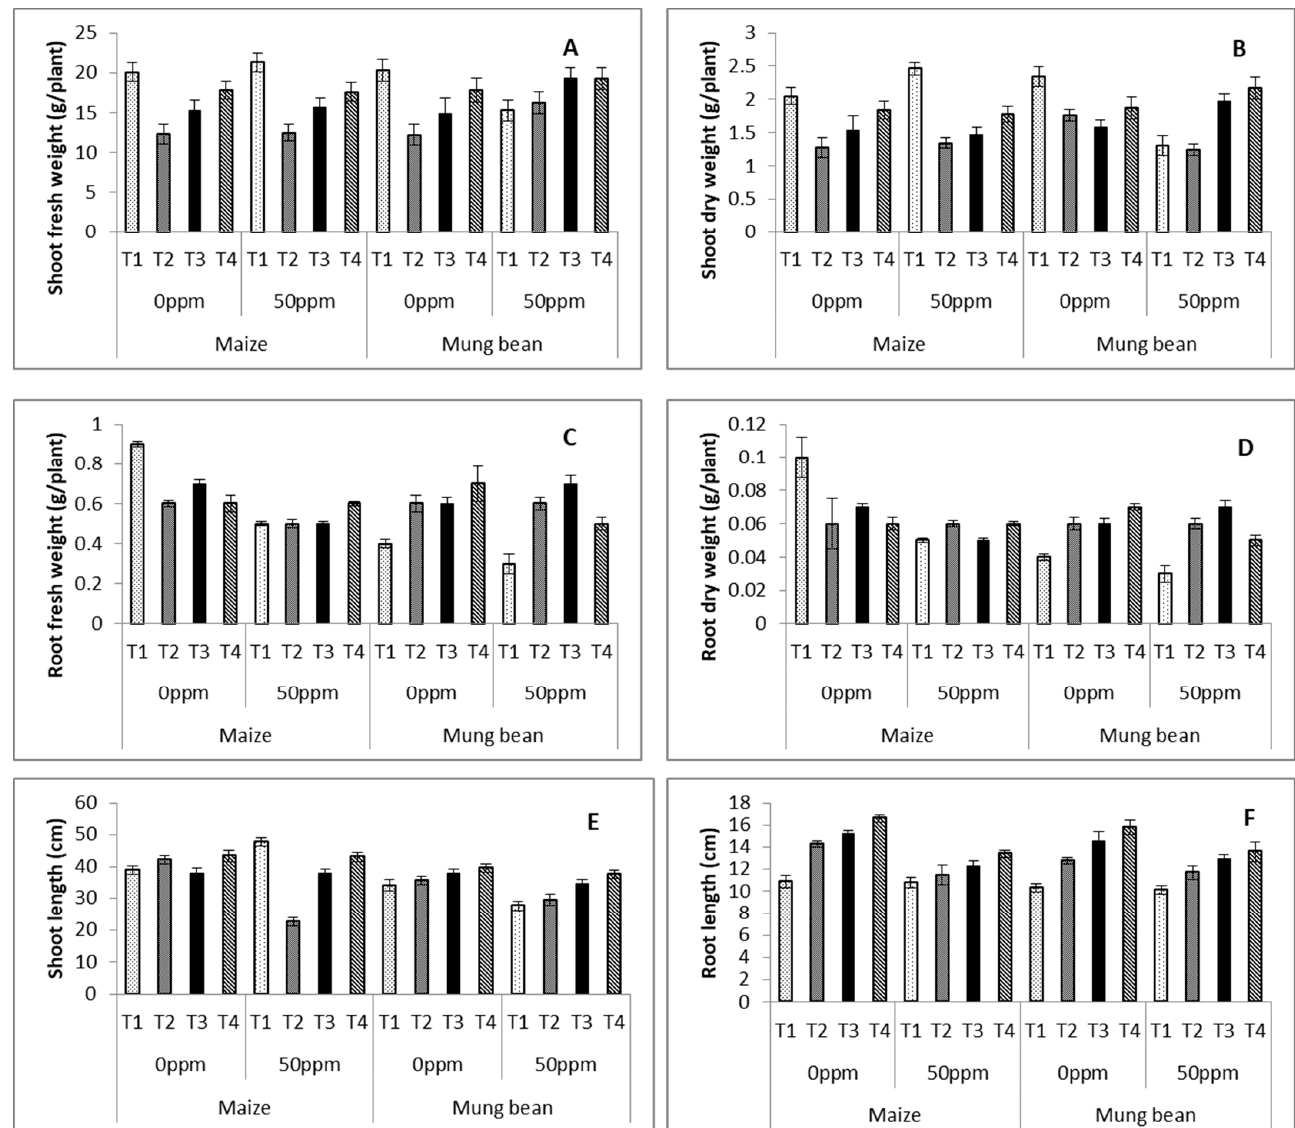
Figure 2. Shoot fresh ( A ) and dry ( B ) weights, root fresh ( C ) and dry ( D ) weights, shoot ( E ) and root ( F ) lengths, of maize ( Zea mays L.) and mung bean ( Vigna radiata L.) exogenously treated with B. subtilis under chromium stress conditions (mean ± S.E.). Here, T1 = Nutrient broth, T2 = Nutrient broth + parent B. subtilis , T3 = Nutrient broth + UV irradiated B. subtilis and T4 = Nutrient broth + γ‐ irradiated B. subtilis .